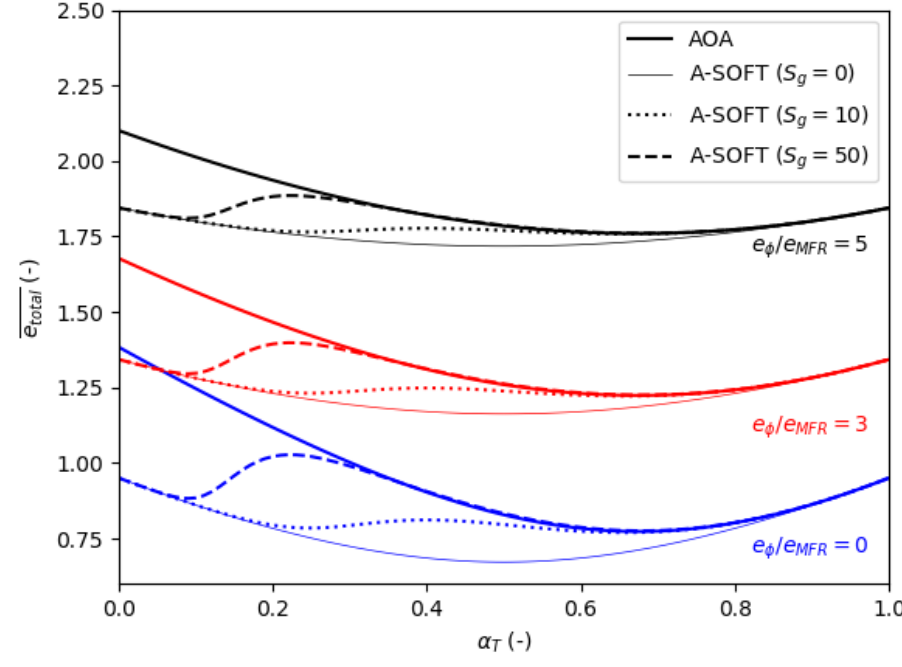
Figure 8. Normalized total